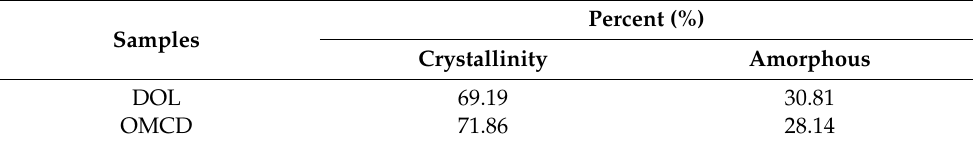
Table 3. Crystallinity of the DOL and OMCD based on XRD